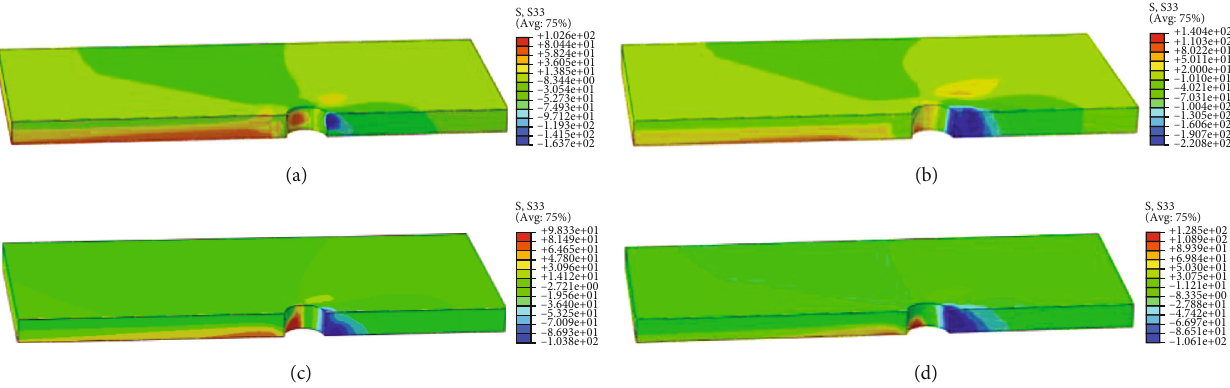
Figure 12: Axial stress contour maps of the composite plate for the joint with 1.2% clearance under various temperatures as the structure is subjected to failure. (a) 25 ° C. (b) 150 ° C. (c) 600 ° C. (d) 750 ° C.